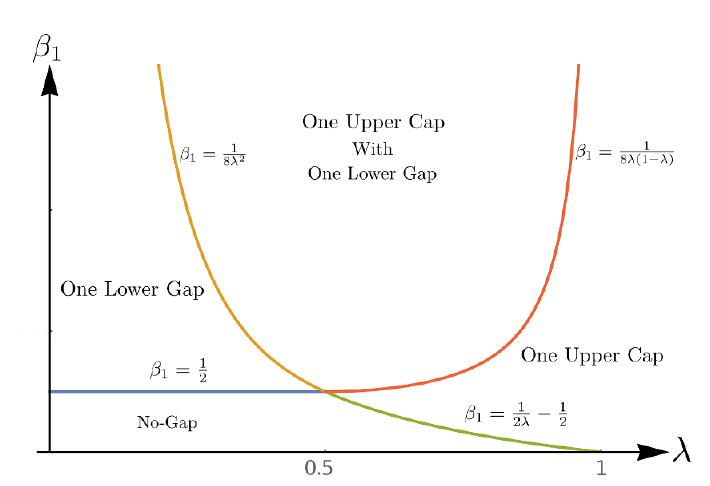
Figure 1 . Phase Diagram for Capped GWW